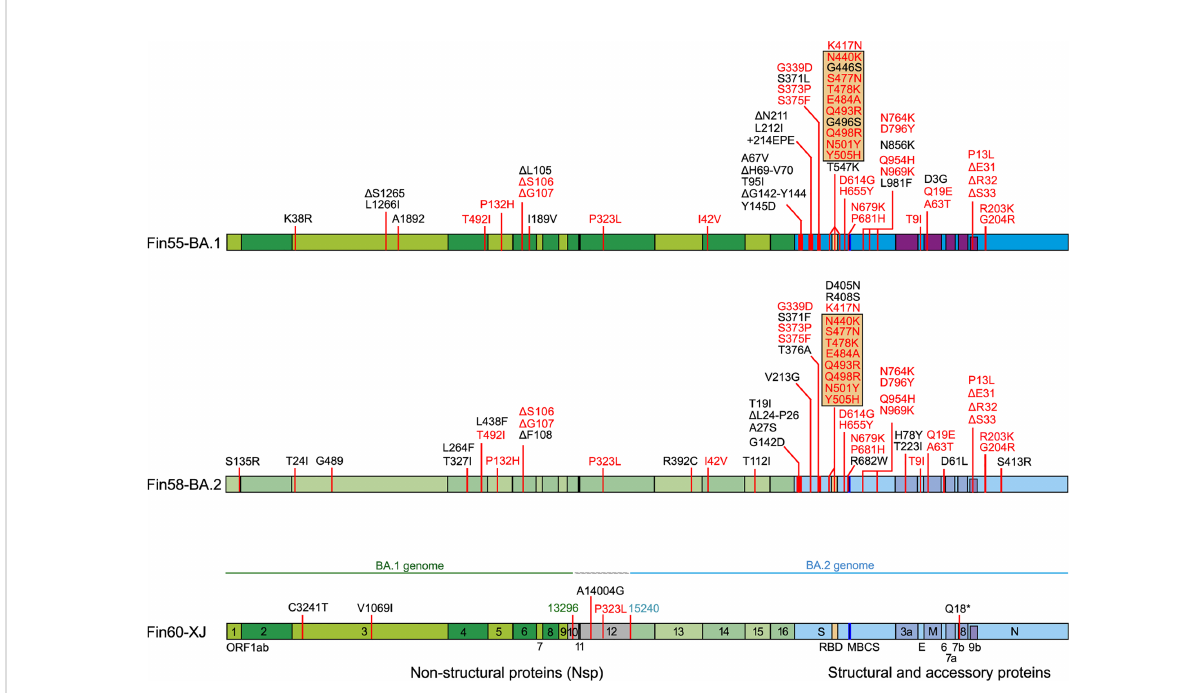
FIGURE 6 Mutations in three Omicron sublineages, Fin55-BA.1, Fin58-BA.2 and recombinant Fin60-XJ. The hCoV-19/Wuhan/WIV04/2019 reference genome (EPI_ISL_402124) was used to map the mutations. In black are unique mutations and in red are mutations that are found in all the above Omicron sublineages. Mutations in the orange box are found in the RBD. Fin60-XJ is a recombinant of BA.1 and BA.2 with a cut off between nucleotides 13 296 (green) in Nsp10 and 15 240 (blue) in Nsp12. Receptor-binding domain (RBD, S protein amino acid residues 437- 507, orange), multi-basic cleavage site (MBCS, S protein amino acid residues 681-685, (P-R-R-A-R), dark